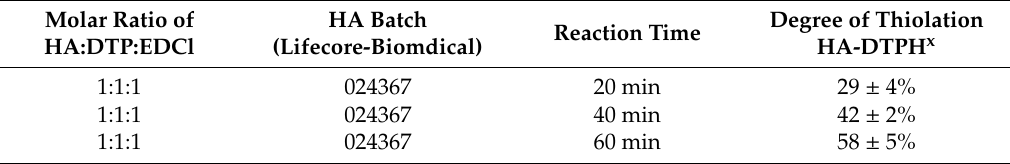
Table 2. Di ff erent degrees of thiolation for 74 kDa HA were achieved with longer reaction times. This table summarizes the di ff erent reaction times, in conjugation with the resulting degrees of thiolation